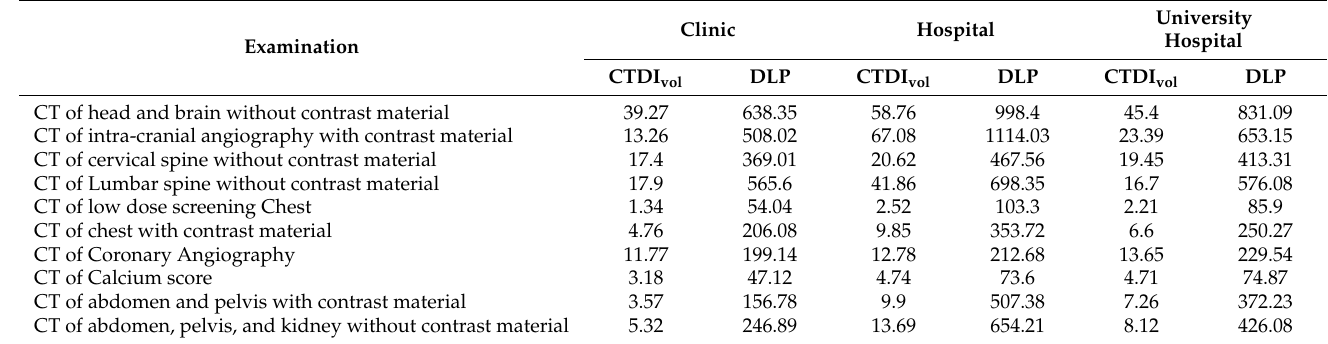
Table 8. Comparison of average CTDI vol and DLP between medical institutions site size